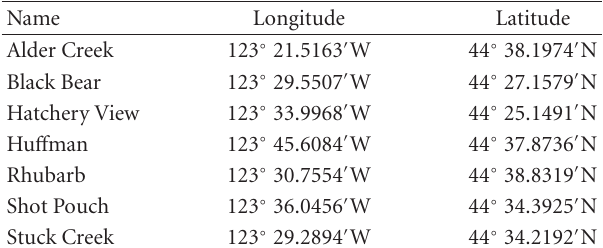
Table 1: Field site locations in Western